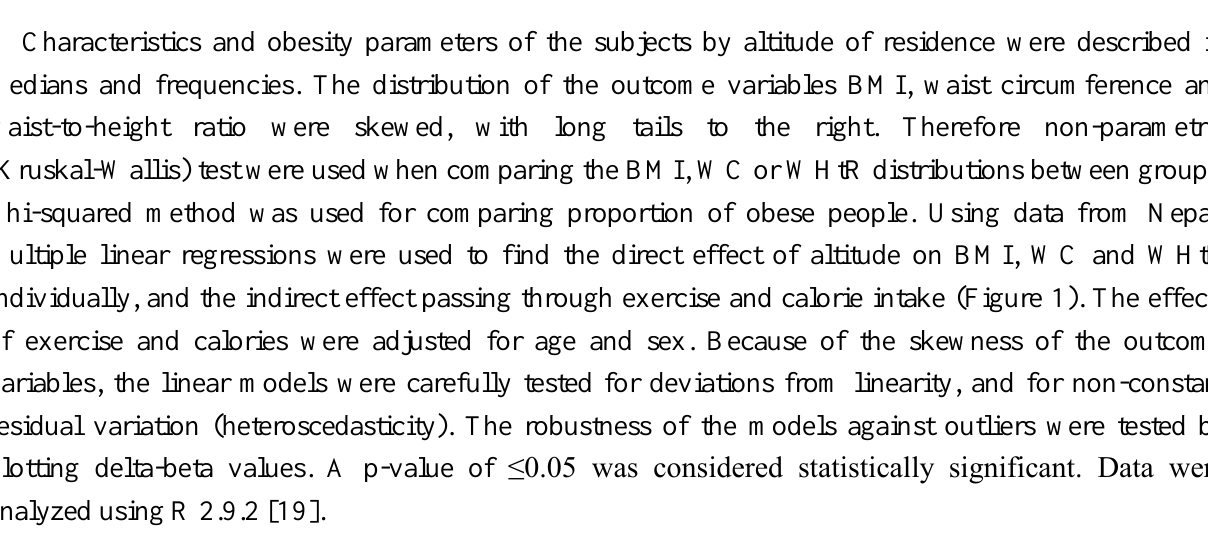
Figure 1. Diagram of possible pathways.